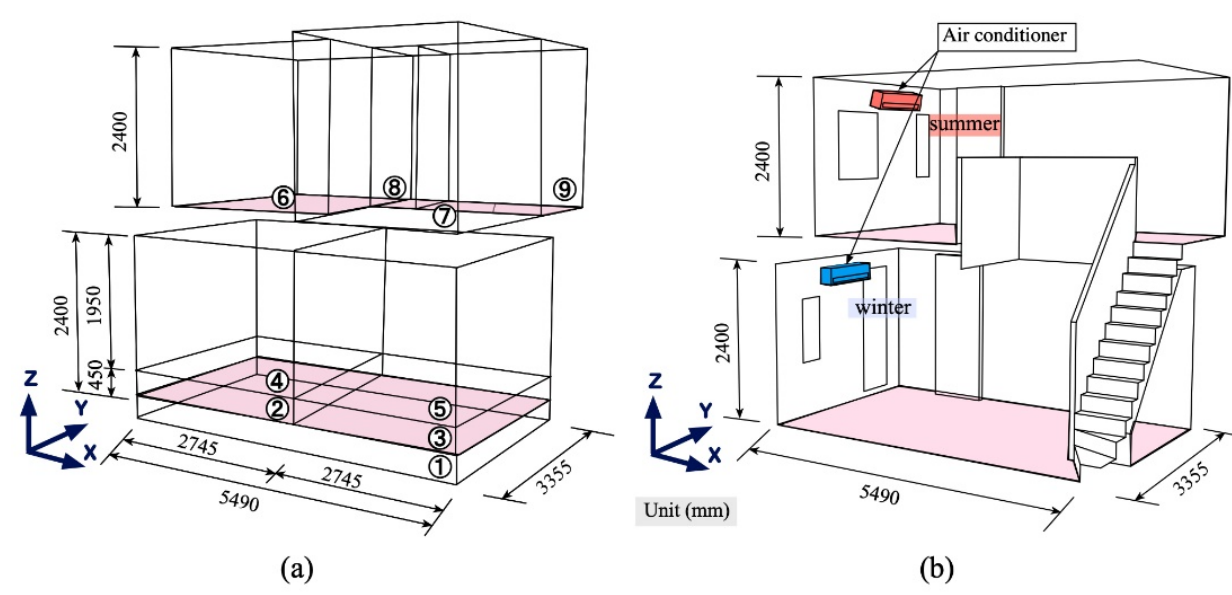
Figure 4. ES and CFD analysis models: ( a ) zoning of the ES; ( b ) CFD analysis model [3].